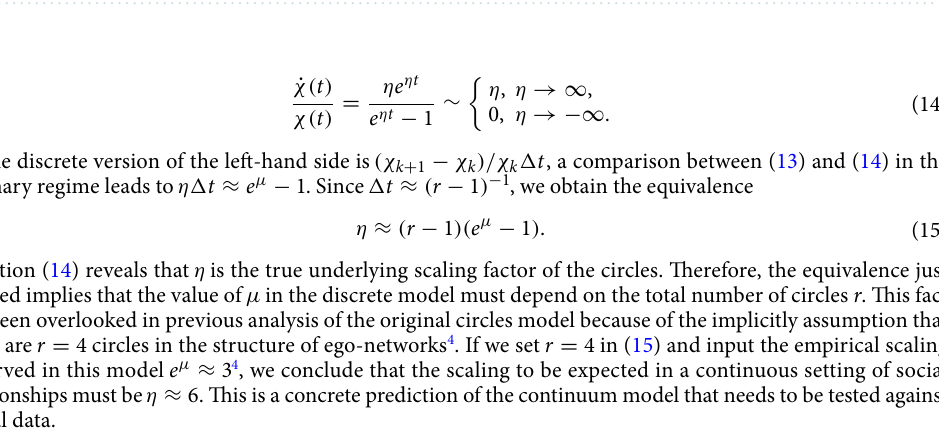
Figure 1. Plot of the function g (η) that determines the cost associated to a value of the scaling parameter η through Eq.